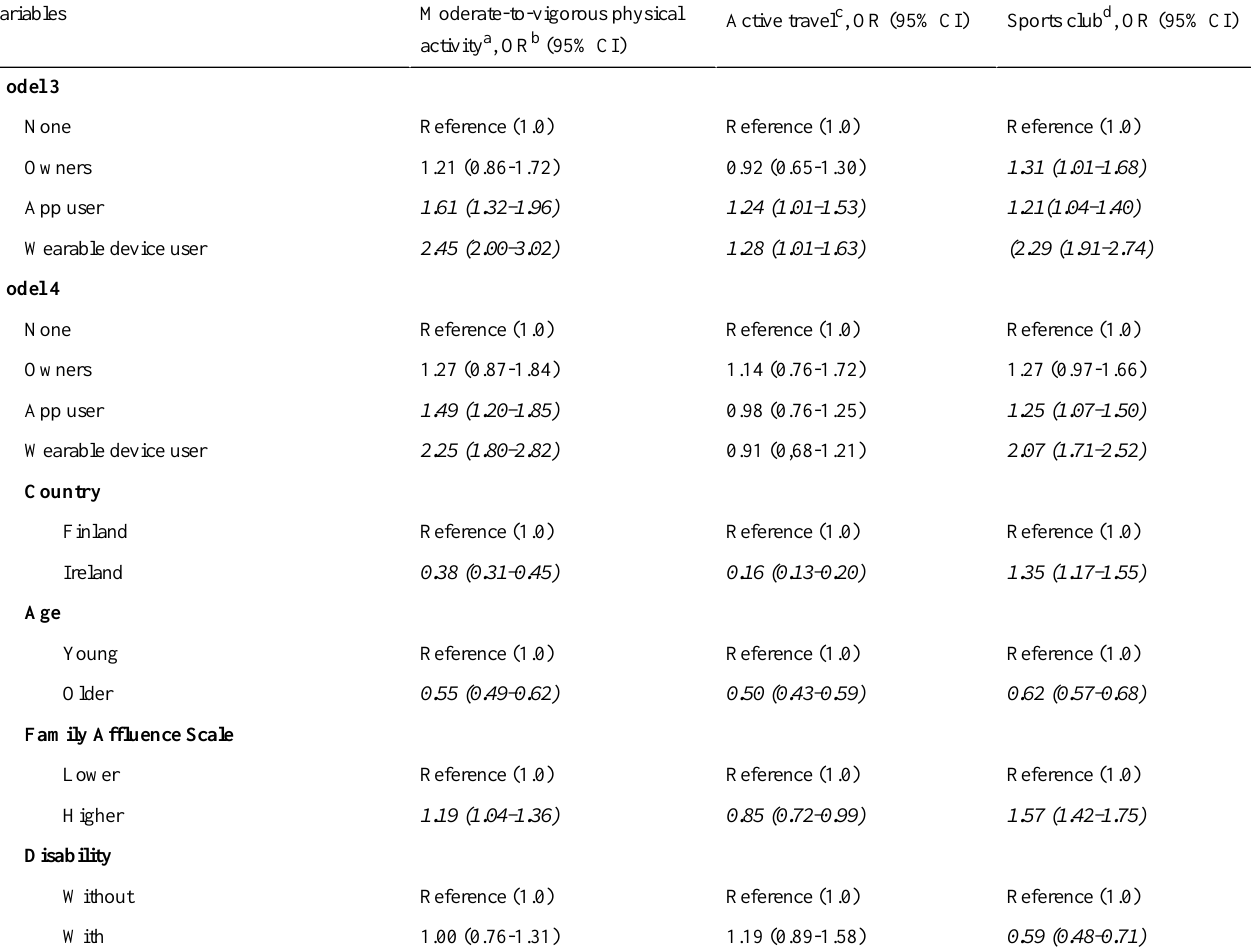
Table 4. Female-adjusted odds ratios and 95% confidence intervals without Model 3 and with Model 4 confounders for each cluster. Italics represents statistically significant